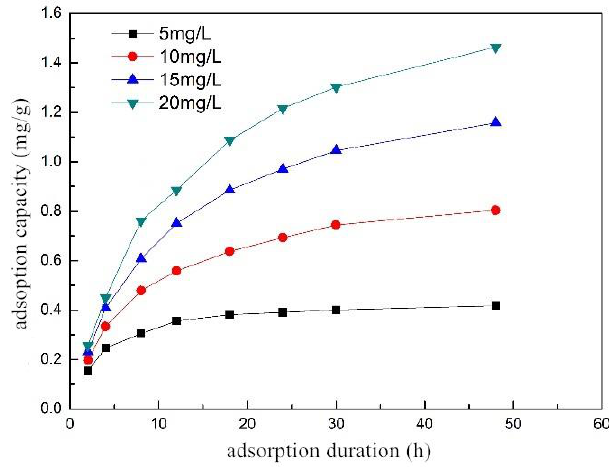
Figure 4. Adsorption kinetic curve of ZSFB composite fiber at di ff erent initial concentrations. Table 3. Kinetics of phosphorus removal by ZSFB composite fiber at di ff erent initial Adsorption Kinetics at Different Temperatures